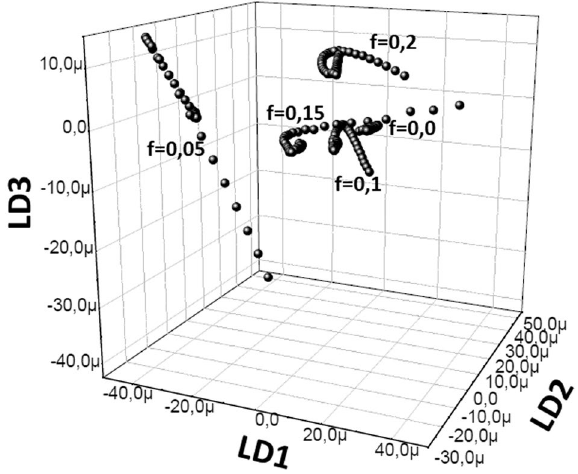
Figure 4. (|LD1 > , |LD2 > , |LD3 > ) points for the electron beam fractions between = . f 0 00 and = . f